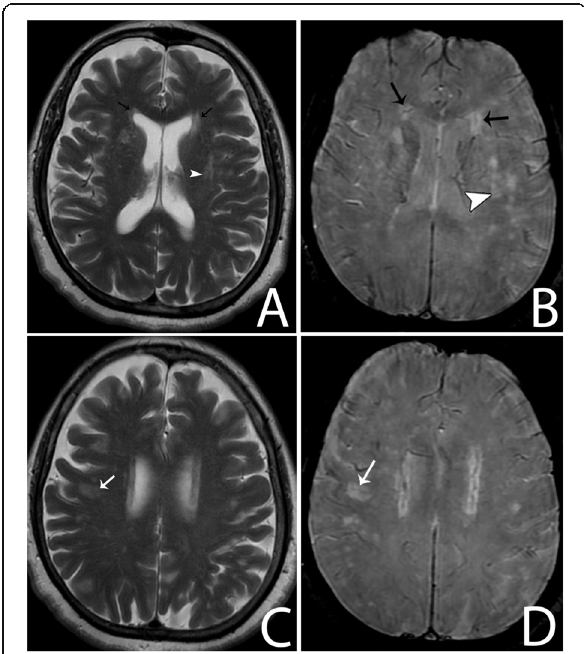
Fig. 6 A 60-year-old male patient with cerebral small vessel disease. Axial ( a and c ) T2WI images show multiple hyperintense periventricular (black arrows), deep white matter (arrow head), and juxta-cortical lesions (white arrow). On corresponding ( b and d ) SWI images, a thin hypointense line representing the CVS is seen in the periventricular (black arrows), deep white matter (arrow head), and juxta-cortical lesions (white arrow)